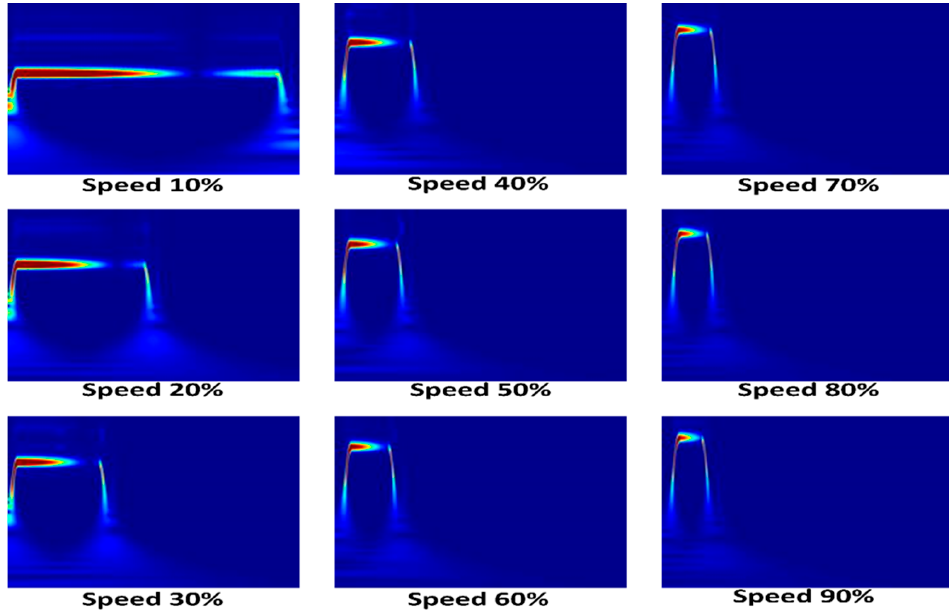
Figure 15. Comparison among different classes; ( a ) RGB images, and ( b ) greyscale images.